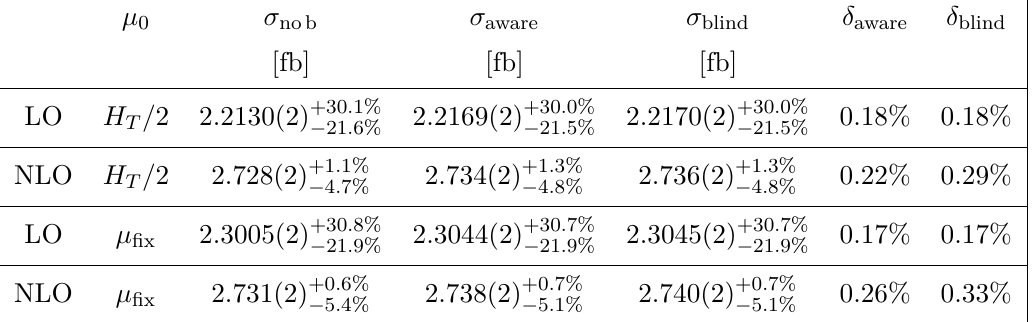
Table 5 . Integrated fiducial cross section at LO and NLO QCD for the pp → e + ν e µ − ¯ ν µ b ¯ b H √ process at the LHC with s = 13 TeV. Results are shown for µ 0 = H T / 2 and µ 0 = µ fix . The NNPDF3.1 PDF set is employed. Predictions are given without and with initial state bottom quark contributions in the charge-aware and charge-blind scheme. Last two columns present the ratio δ X = ( σ X − σ no b ) /σ X